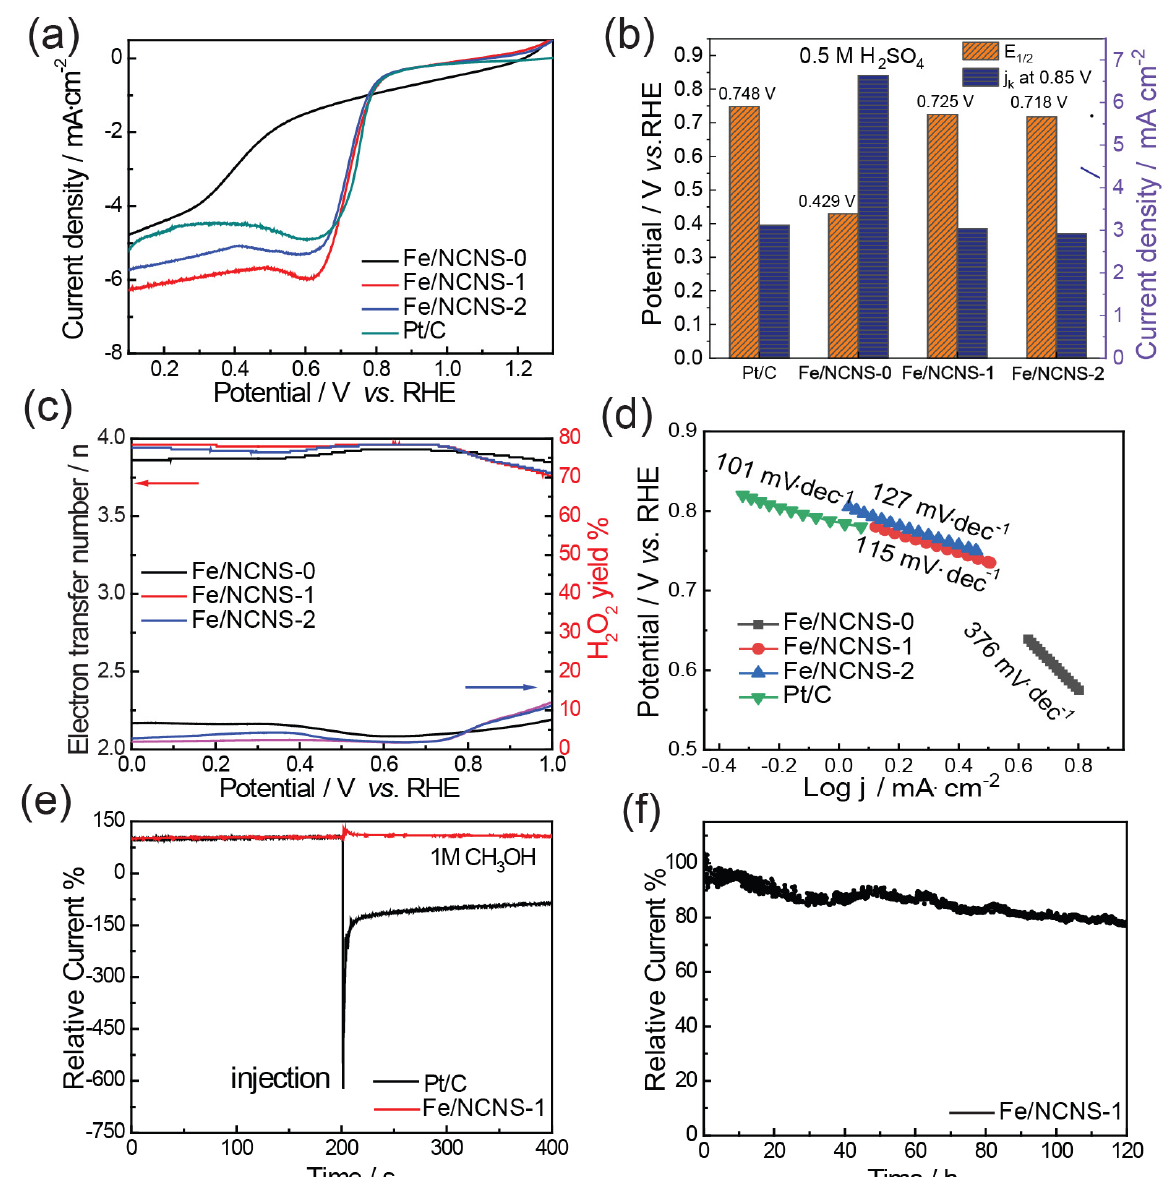
Figure 3. ( a ) LSV curves of Fe/NCNS-0, Fe/NCNS-1, Fe/NCNS-2 and commercial Pt/C at 1600 rpm · min − 1 in 0.5 M H 2 SO 4 , ( b ) comparison of j k at 0.85 V and E 1/2 of Fe/NCNS-0, Fe/NCNS-1, Fe/NCNS-2 and commercial Pt/C, ( c ) electron transfer number (n) and the yield of H 2 O 2 ; ( d ) Tafel plots of Fe/NCNS-0, Fe/NCNS-1, Fe/NCNS-2 and commercial Pt/C, ( e ) the tolerance to methanol of Fe/NCNS-1 and commercial Pt/C, ( f ) electrochemical stability test of Fe/NCNS-1 in 0.5 M H 2 SO 4 . The Electrocatalytic ORR performance of the Fe/NCNSs in 1 M KOH electrolyte was also investigated. The CV curves of Fe/NCNSs are shown in Figure S6. Distinct charac- teristic peaks were not also observed on the CV curves of Fe/NCNSs in the N 2 -saturated electrolyte, while the CV curves in the O 2 -saturated electrolyte all exhibited obvious ca- thodic peaks. LSV curves and the comparison of half-wave potential and j K at 0.85 V are displayed in Figure 4a,b. Fe/NCNS-1 exhibited the best ORR activity with the half-wave potential of 0.865 V, more positive than that of commercial Pt/C (0.841 V), Fe/NCNS-2 (0.851 V) and Fe/NCNS-0 (0.753 V). The outstanding ORR activity of Fe/NCNS-1 is further confirmed with its high kinetic current density (j K ) at 0.85 V (vs. RHE) of 22.3 mA · cm − 2 , which is 1.3 and 4.7 times those of Pt/C (17.1 mA · cm − 2 ) and Fe/NCNS-0 (4.7 mA · cm − 2